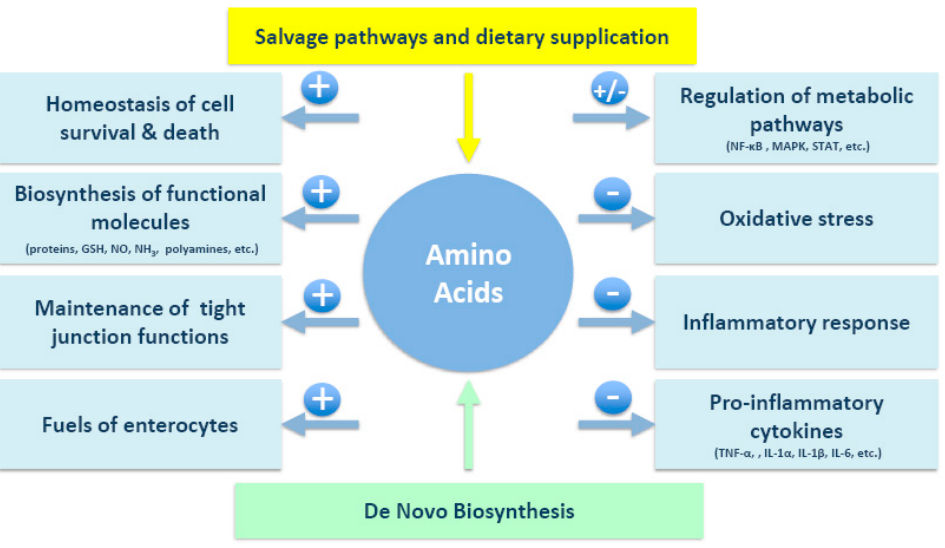
Figure 1. Projected mechanisms by which amino acids exert their beneficial effects on IBD. GSH, glutathione; IL, interleukin; MAPK, mitogen-activated protein; NF- κ B, nuclear factor- κ B; NO, nitric oxide; STAT, signal transducers and activators of transcription; TNF- α , tumor necrosis factor- α